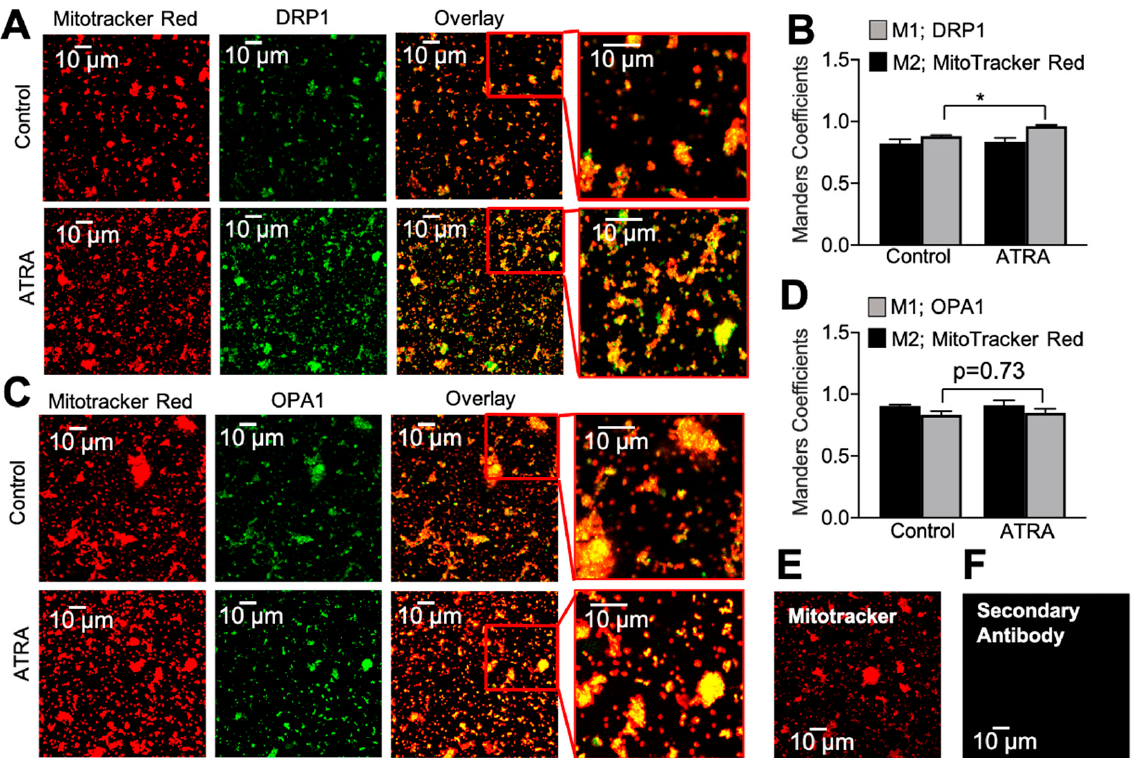
Figure 3. Quantification of mitochondrial localization of DRP1 and OPA1 by confocal microscopy. ( A ) Mitochondria were labeled with antibodies against DRP1 and ( C ) OPA1 in purified cardiac mitochondrial clusters from vehicle- (upper panels) and ATRA- (lower panels) treated mice. Red channel: MitoTracker™ Red. ( B ) and ( D ) Mander’s coefficient of colocalization between MitoTracker™ Red (M2; black bars) and DRP1 (M1; gray bars) vs. OPA1 (M1; gray bars), respectively. In ATRA treatment, there was a significant increase in DRP1 colocalization with MitoTracker™ Red (* p < 0.01, vs. vehicle; unpaired 2-sample t -test; n = 3 mice; n = 12 images) ( B ) but no change in OPA1 ( n = 3 mice; n = 12 images) ( D ). Mitochondria were loaded with MitoTracker™ Red ( E ) and labeled with secondary antibody alone ( F ).